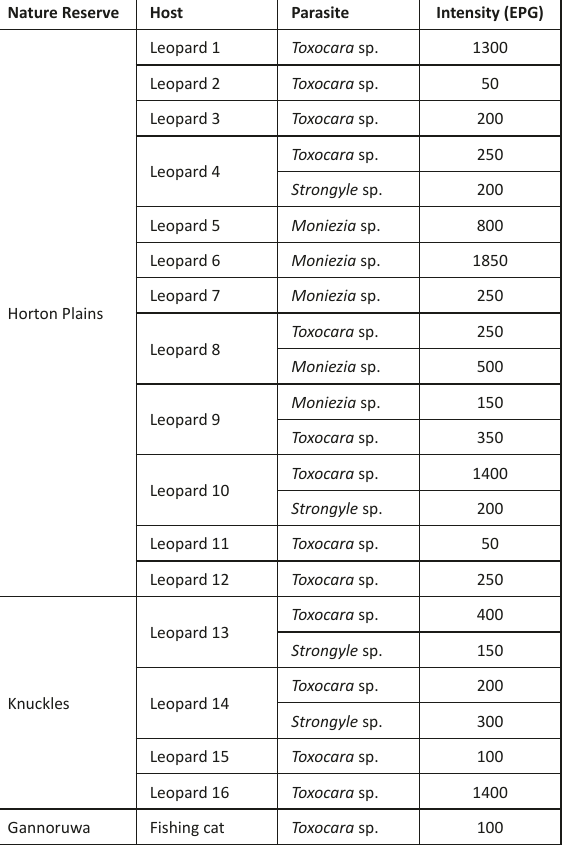
Table 3. Information on the intensity of parasite infections in the wild Leopard and Fishing cat positive samples